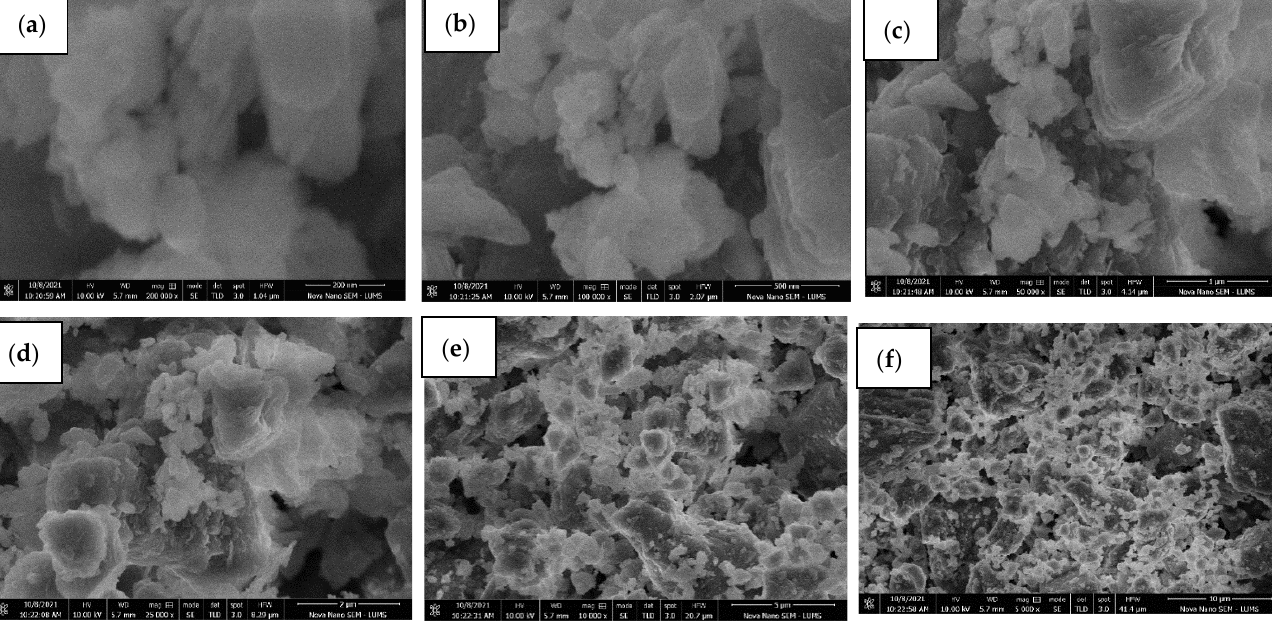
Figure 7. SEM images of potassium ferricyanide treated golden marble powder at various resolu-